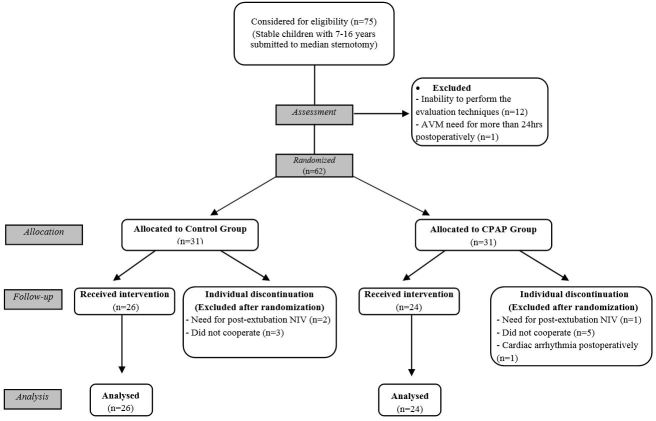
CONSORT flowchart.